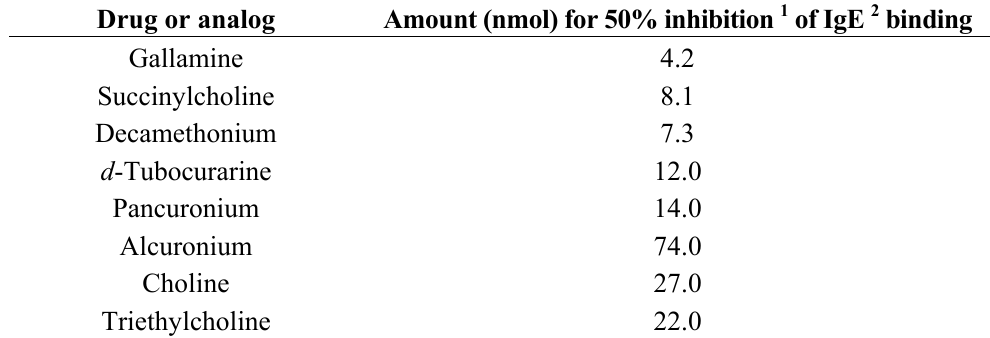
Table 3. Demonstration of specificity and allergenic cross-reactivity between NMBDs demonstrated by IgE antibodies to gallamine.